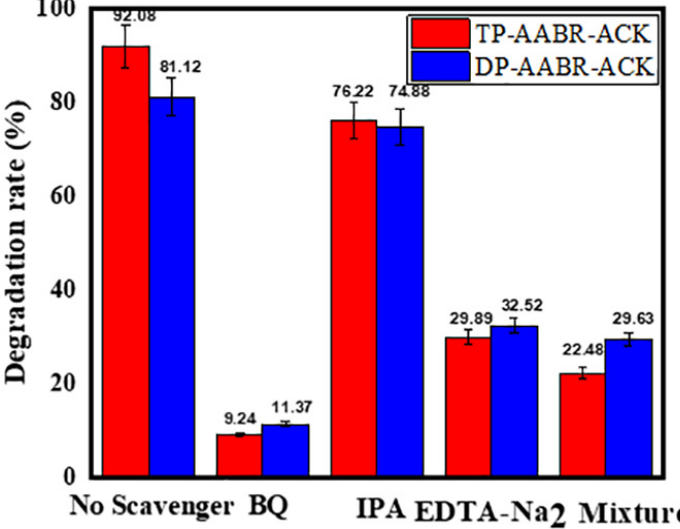
Figure 10. Photocatalytic degradation of TC solution over active AABR-ACK nanocomposites with scavenger agents.